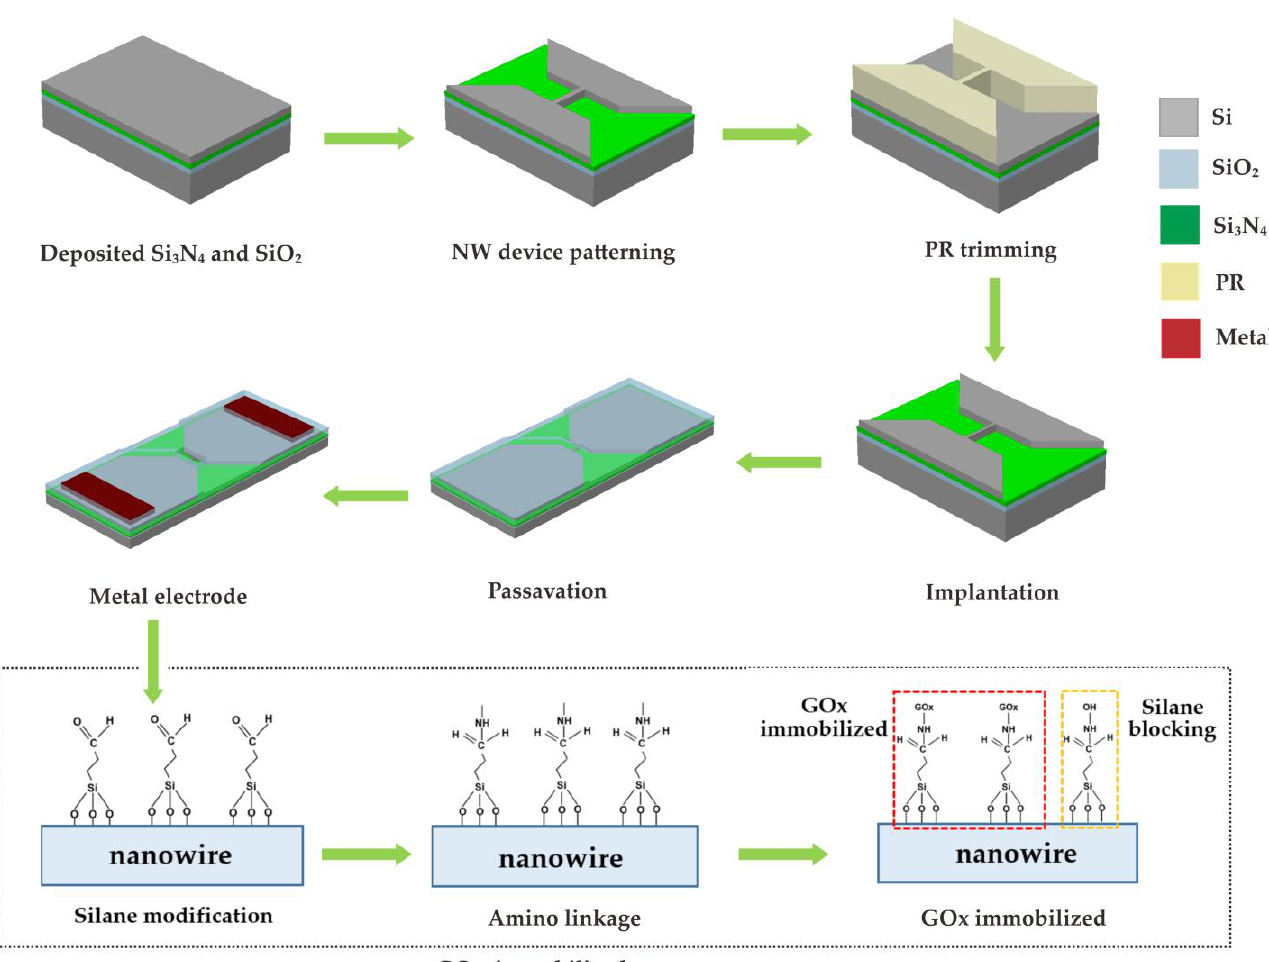
Figure 1. Schematic of the fabrication procedures of NWGS. After fabricating the nanowire devices, the devices were covered with a 10% ( v / v ) ethanol solution of 3-aminopropyltriethoxysilane (APTES) for 15 min at room temper- ature. The solution was then removed and baked at 100 ◦ C for 45 min to modify the nanowire’s surface. To covalently immobilize GOx on SiO 2 , 0.01% suberic acid bis(3-sulfo- N-hydroxysuccinimide ester) sodium salt (BS3) was mixed in 10 mM phosphate